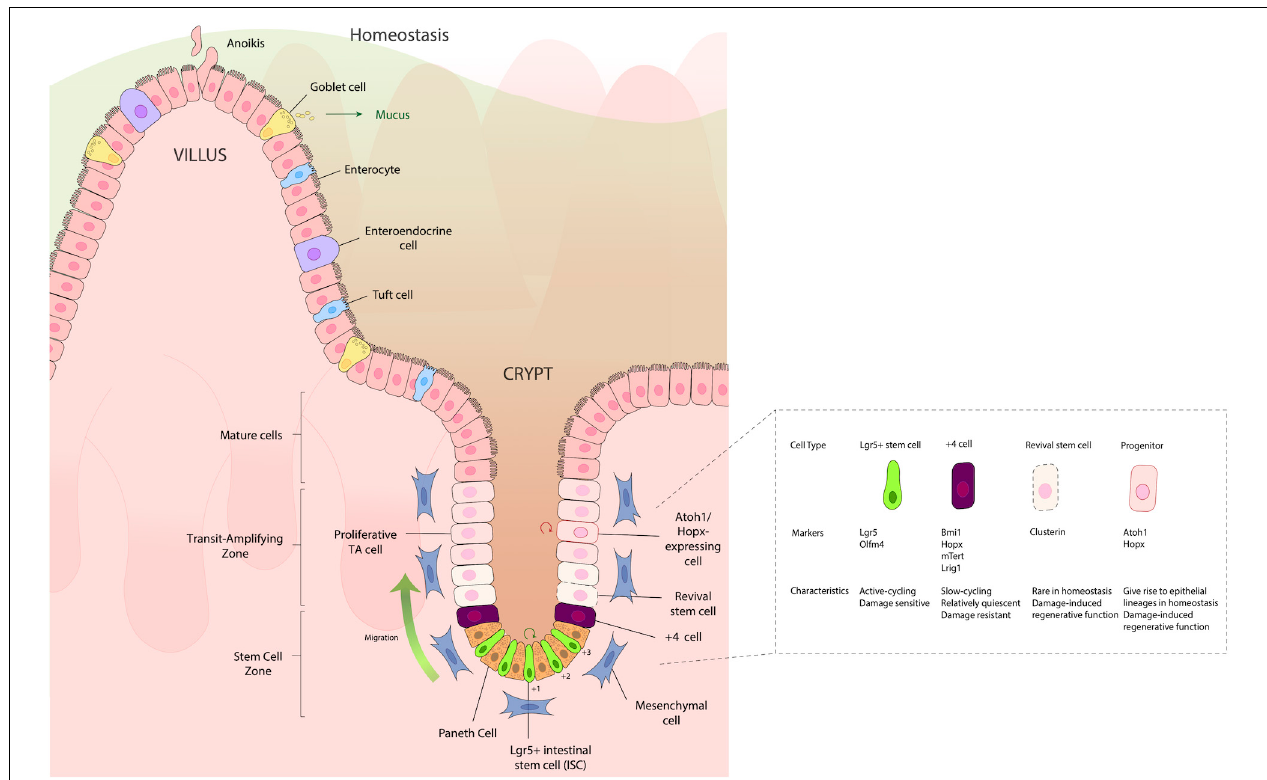
FIGURE 1 | Structure of the intestinal epithelium. The intestinal epithelium is replenished every 3–4 days by rapidly dividing Lgr5 + intestinal stem cells (ISCs) in the crypt base that differentiate as they move up the crypt villus axis, until they eventually slough into the lumen. Situated between the small intestinal ISCs are Paneth cells, which are important for providing signaling molecules such as WNT, epidermal growth factor (EGF) and Notch ligands (DLL1, DLL4), which aid in the maturation and differentiation of ISCs to either absorptive (enterocytes), secretory [Goblet cell, enteroendocrine (EE)], or Tuft cell lineages. Just above the IECs, frequently in the “+4” position, are slow cycling, damage resistant cells that express the markers Bmi1, Hopx, mTert, and Lrig1. Located in the transit amplifying zone are Atoh1 and Hopx-expressing mature cell precursors, which give rise to different epithelial lineages during homeostasis, but during damage, have a regenerative function, helping aid in re-establishing damaged